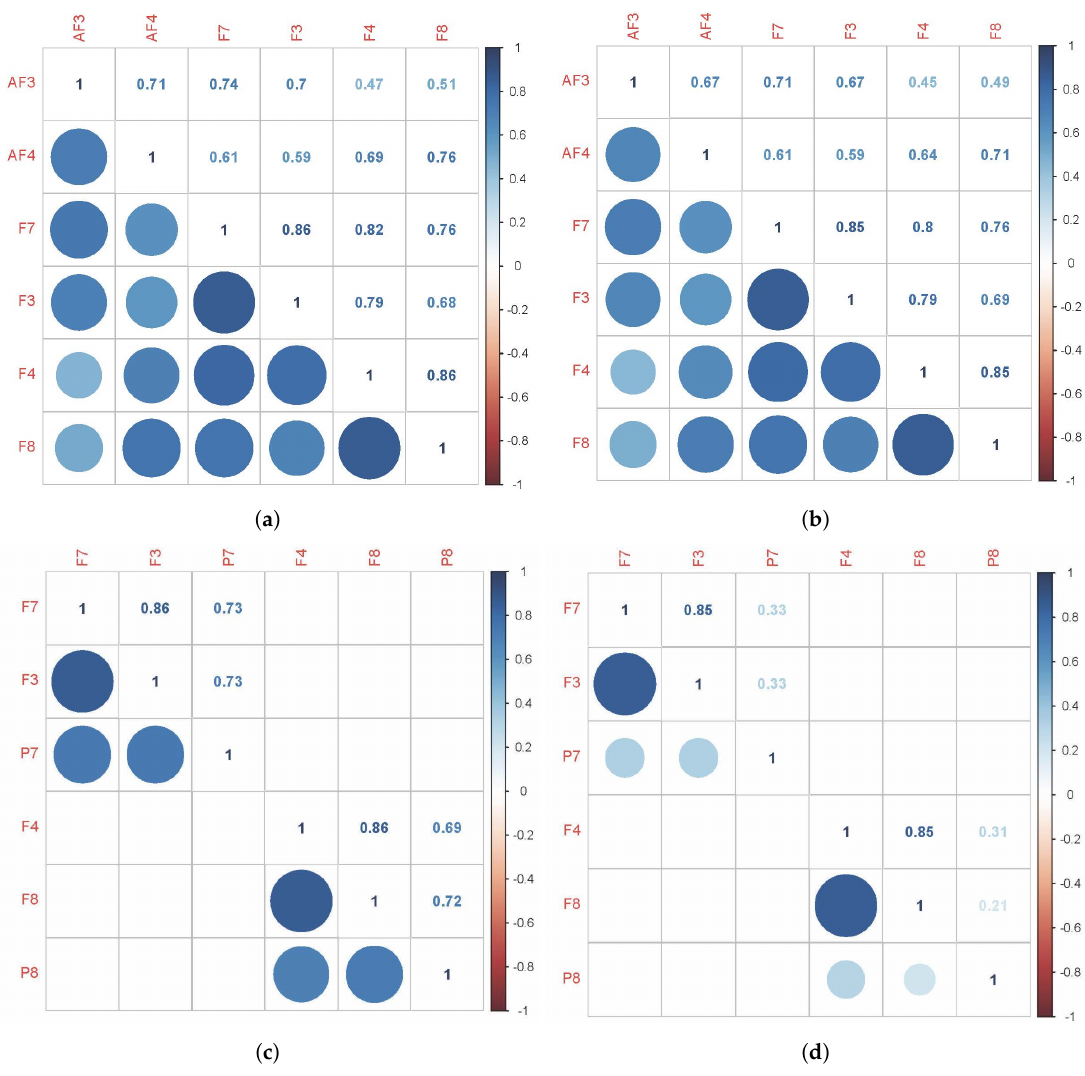
Figure 8. Graphical representation of Hypotheses confirmation with Subject 1 results. ( a ) (CPD)nA Results. Sensors AF3-F7-F3-AF4-F4-F8 . ( b ) KATA Results. Sensors AF3-F7-F3-AF4-F4-F8 . ( c ) (CPD)nA Results. Sensors F7-F3-P7-F4-F8-P8 . ( d ) KATA Results. Sensors F7-F3-P7-F4-F8-P8